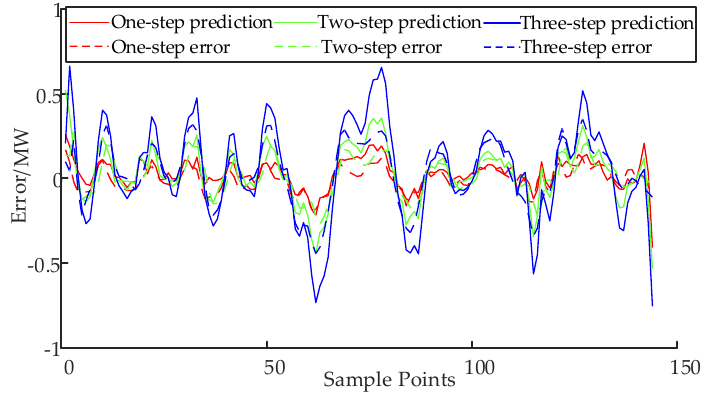
Figure 6. One-two-three-step error value and prediction error value.